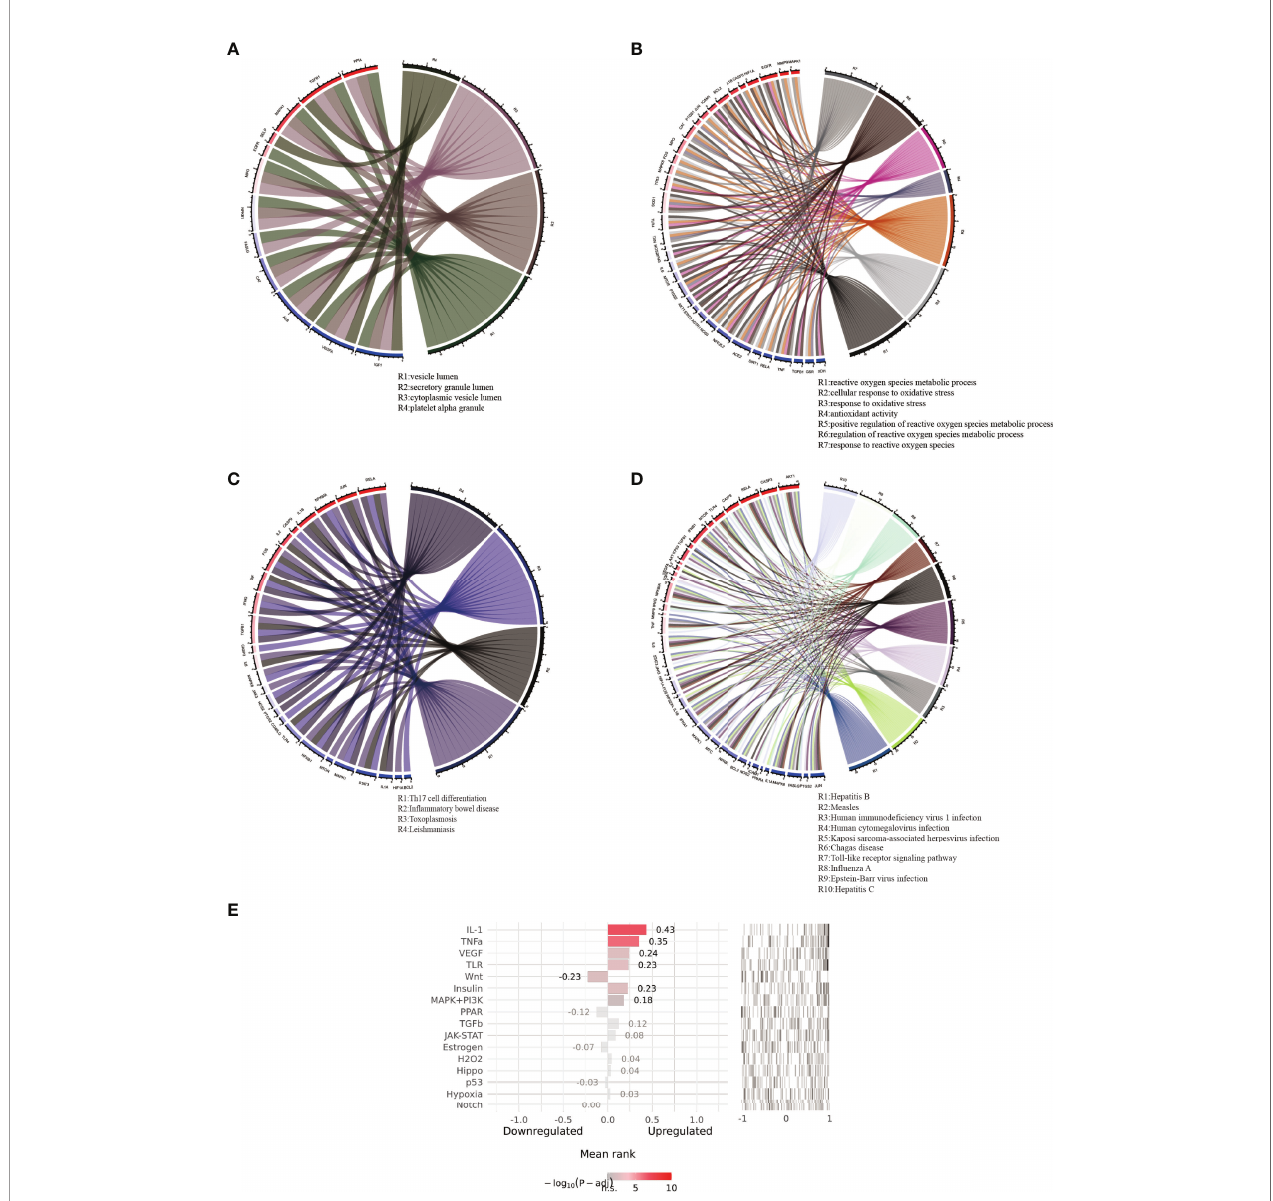
FIGURE 5 | Pathways with high correlation and corresponding common genes. (A, B) respectively displayed the highly correlated pathways and corresponding common genes of GO term rich base results. (C, D) displayed the highly correlated pathways and corresponding common genes of KEGG pathway enrichment results. (E) displayed the results of upstream pathway activity analysis for 69 common